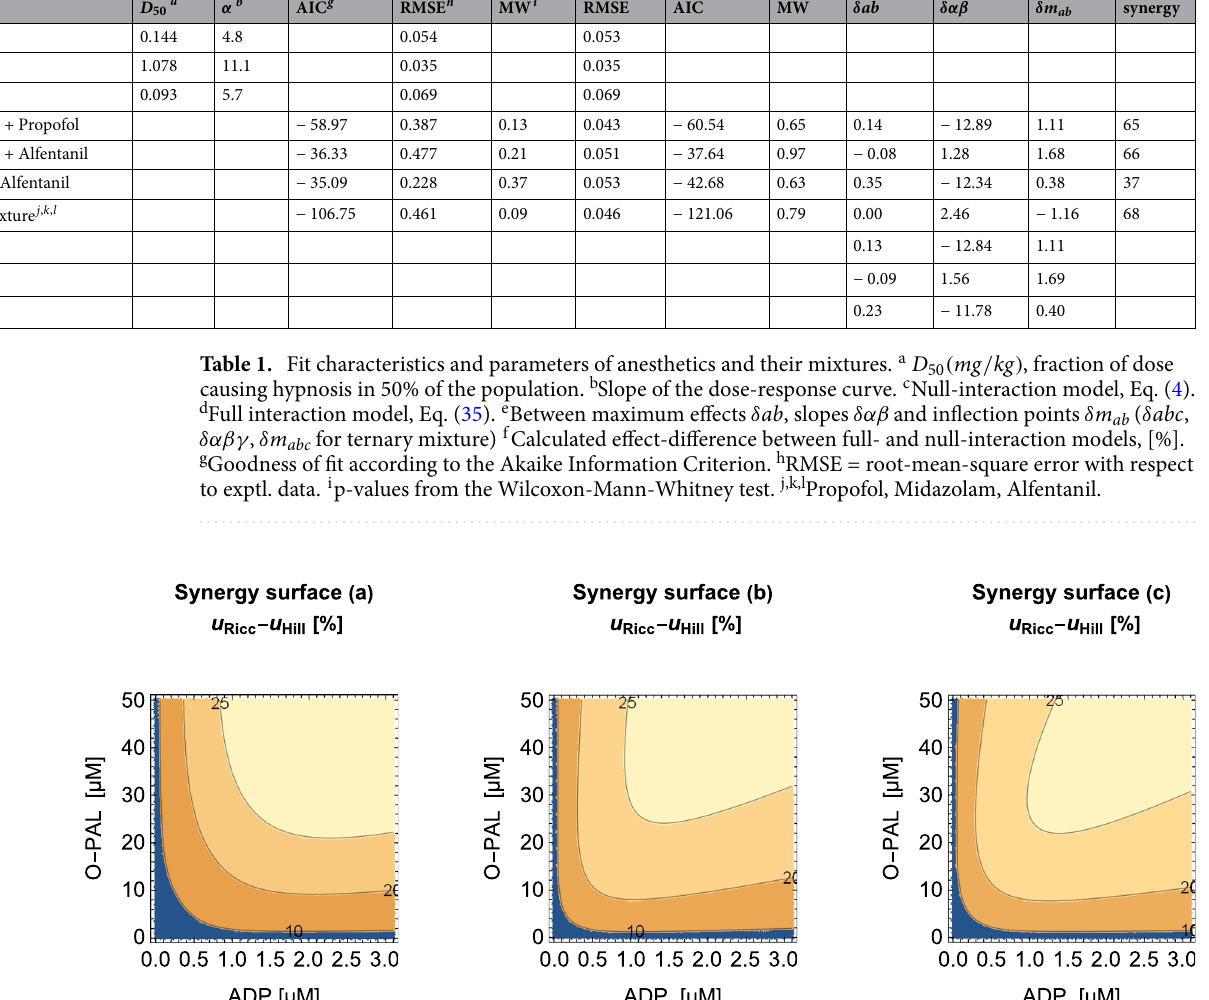
Figure 1. Contour plots of ADH inhibitor synergy surfaces u Ricc − u Hill (in %) using different parameter sets for u Ricc . The u Ricc surfaces contain ( a ) δ ab -only, ( b ) all interaction parameters δ ab , δ m ab and δαβ , and ( c ) the full-parameter